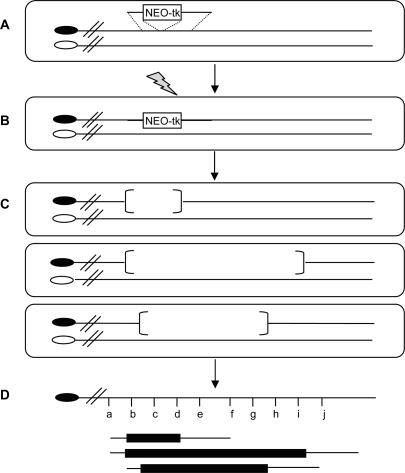
Generation and Characterization of Radiation-Induced Deletion Complexes in Mouse ES Cells(A) Insertion of a negative selectable marker (cassette Neo-tk: Hsv-thymidine kinase/neomycin resistance) into a predetermined locus by homologous recombination in F1 hybrid (129/SvJae x C57BL/6J) ES cells (C57BL/6J chromosome represented with a black centromere; 129/SvJae chromosome represented with a white centromere).(B) Treatment of the neomycin-resistant targeted cells with radiation to induce the deletions.(C) Selection in medium containing 1,2′-deoxy-2′-fluoro-β-D-arabinofuranosyl-5-iodouracil of the colonies having lost the tk gene.(D) Characterization of the deletion breakpoints by amplification of the DNA from these clones using primers corresponding to genetic polymorphic markers (represented under the chromosome map by letters a–j) flanking the site of the targeted integration. Deletions are represented as solid boxes.